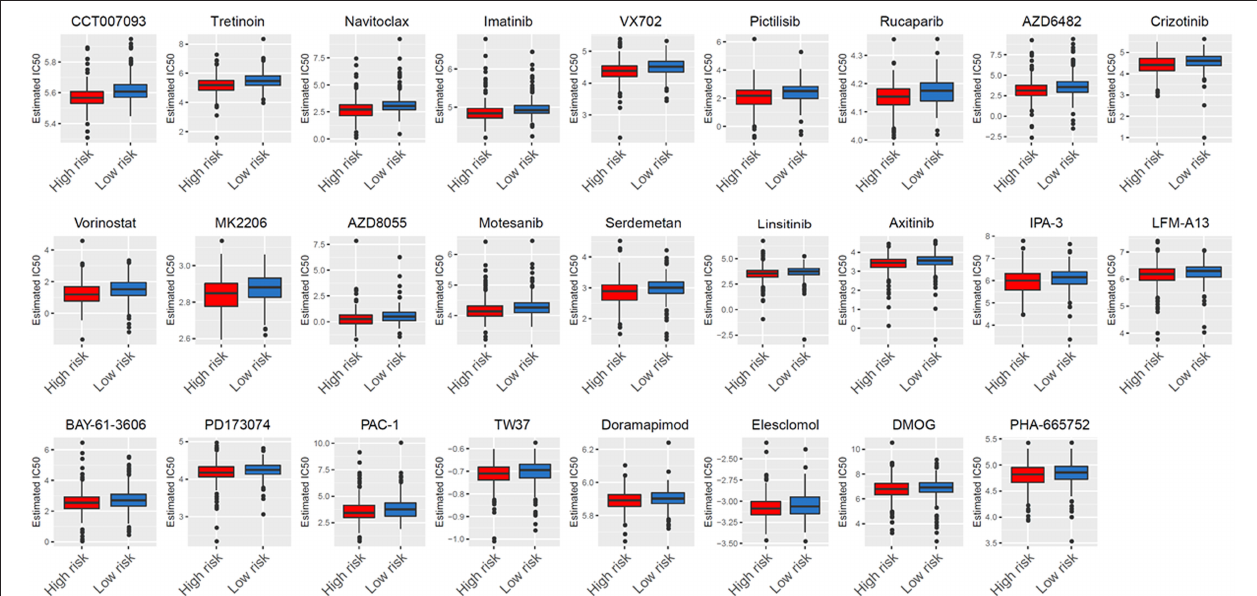
FIGURE 9 | Analysis of GDSC database identifies novel candidate compounds targeting the glycolysis-related gene model.